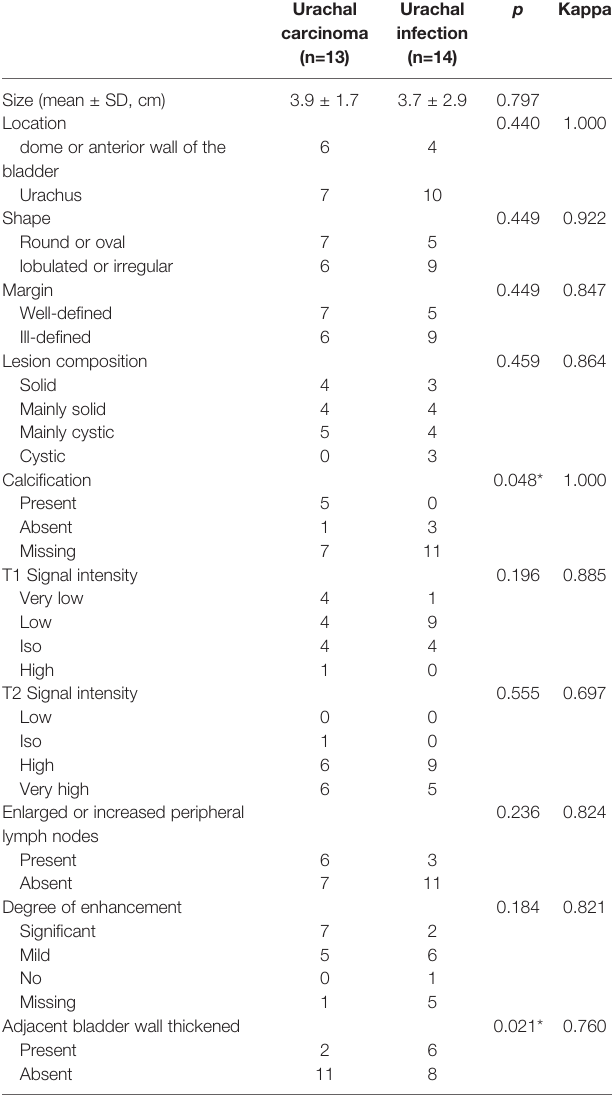
Data are number of patients. SD, standard deviation. *Signi fi cant